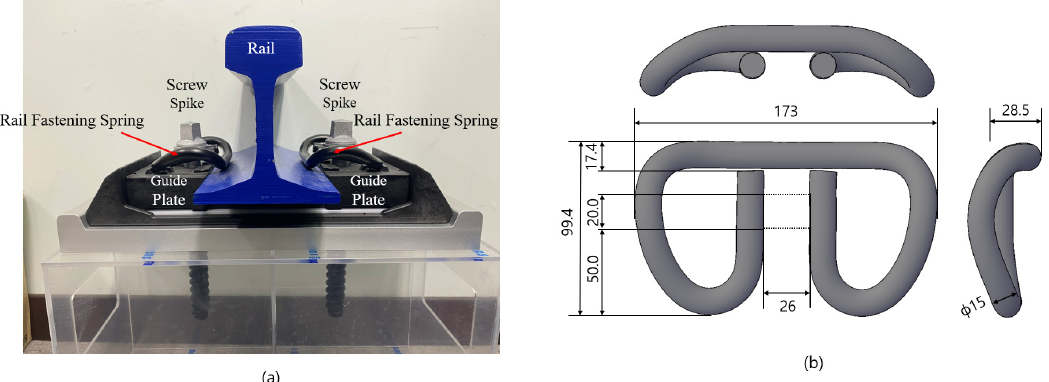
Figure 1. KR-type rail fastening system: ( a ) assembled configuration; ( b ) geometry of fastening